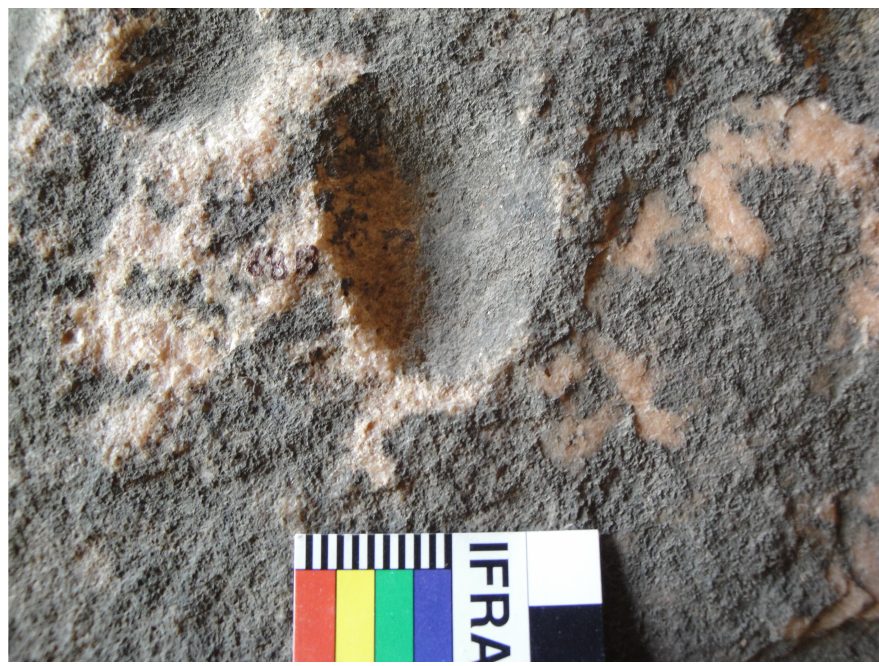
Figure 8. Oval shaped cupule on northernwall in